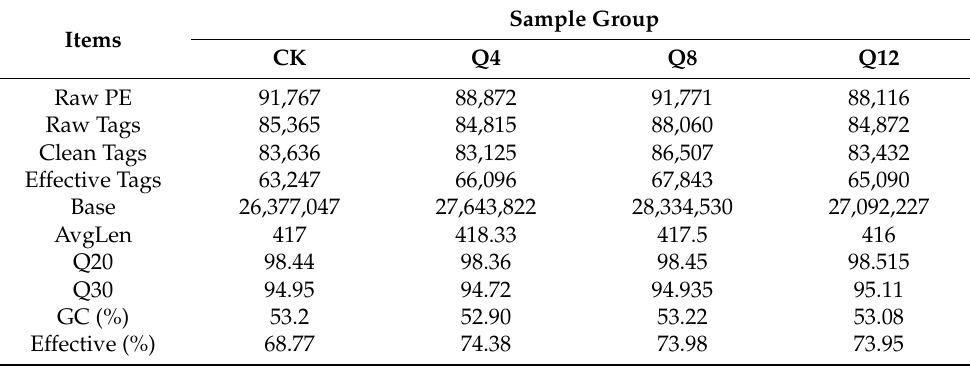
Table 4. Statistics of sample sequencing data processing